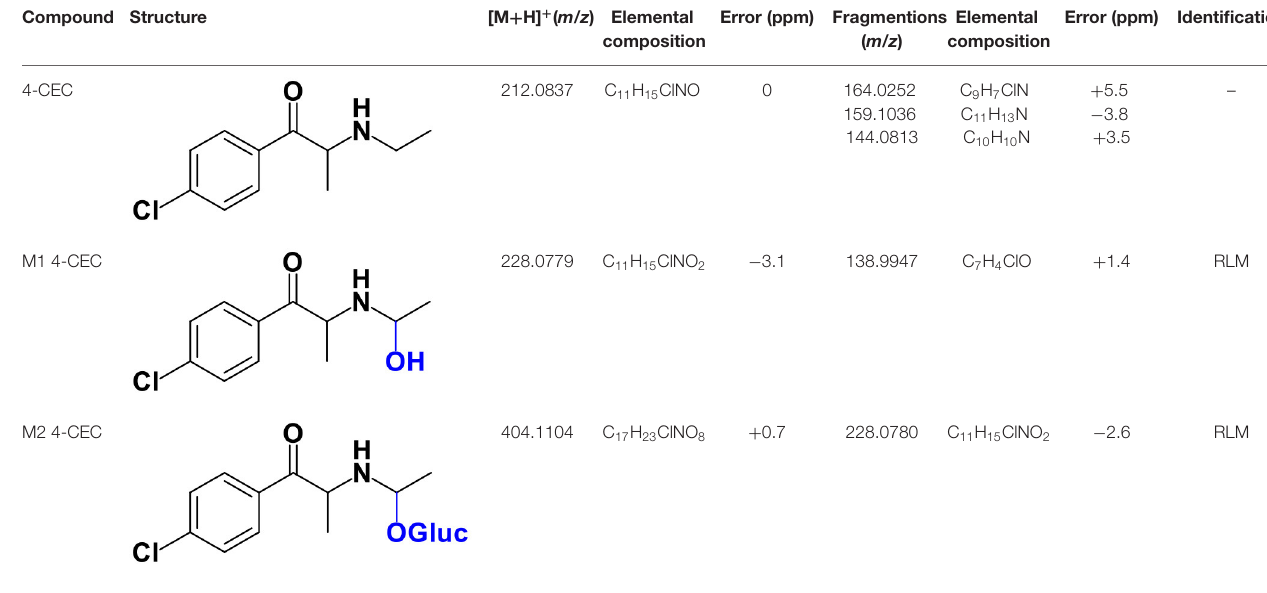
TABLE 5 | Structures of the 4-CEC metabolites identified in RLM incubations by LC-HRMS/MS (ESI + ) analysis. Compound